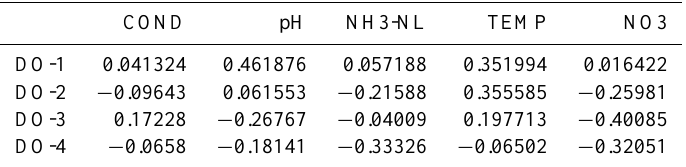
Table 3. The correlation coefficient between DO and the input